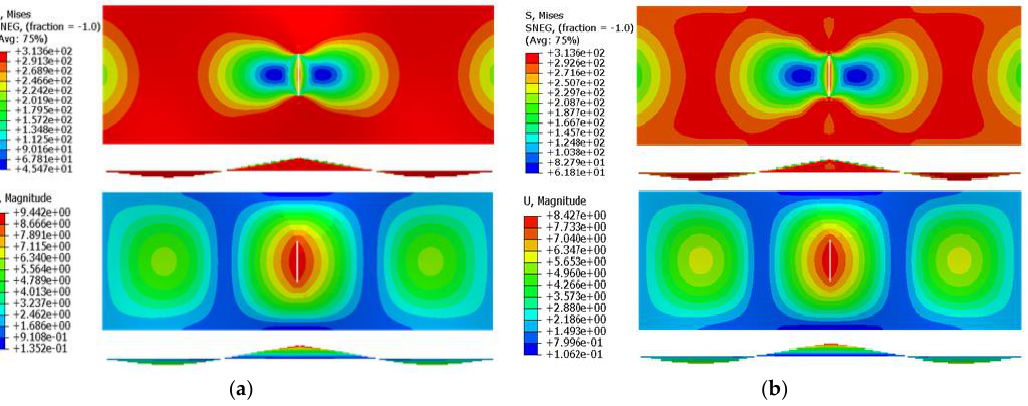
Figure 16. The stress distribution and out-of-plane deformation at the compressive limit: ( a ) plate with prefabricated crack; ( b ) plate with fatigue crack.